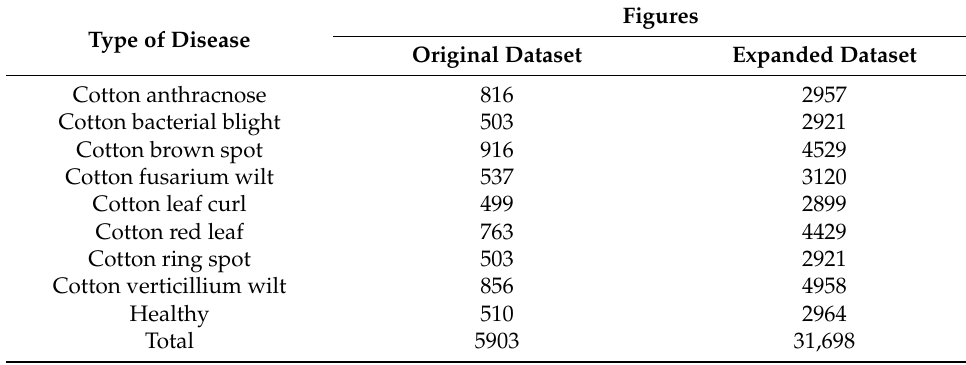
Figure 1. Examples of image enhancement. Table 2. Details of the constructed cotton leaf disease dataset.